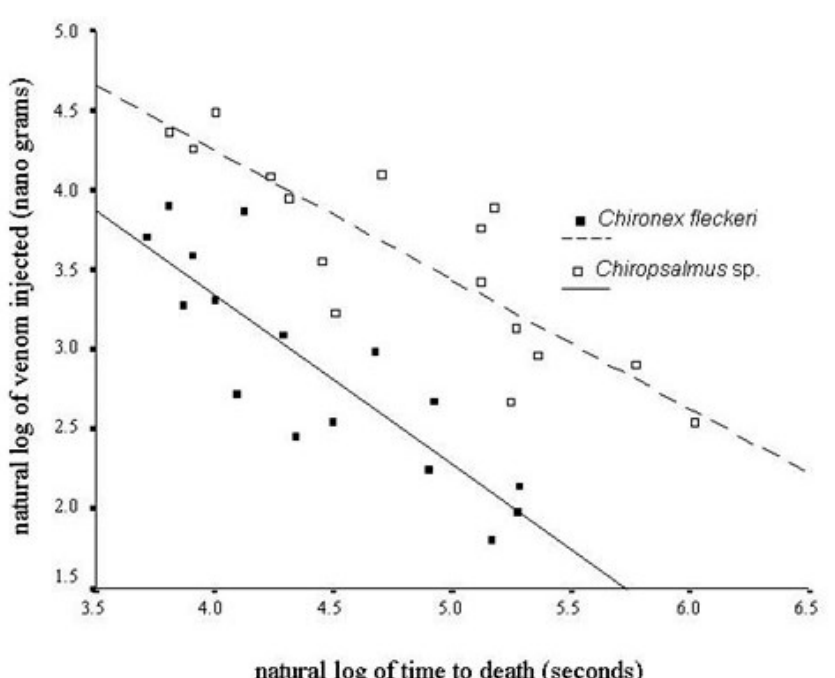
Figure 1: Natural log of venom concentration over natural log of time to death for Chironex fleckeri and Chiropsalmus sp.